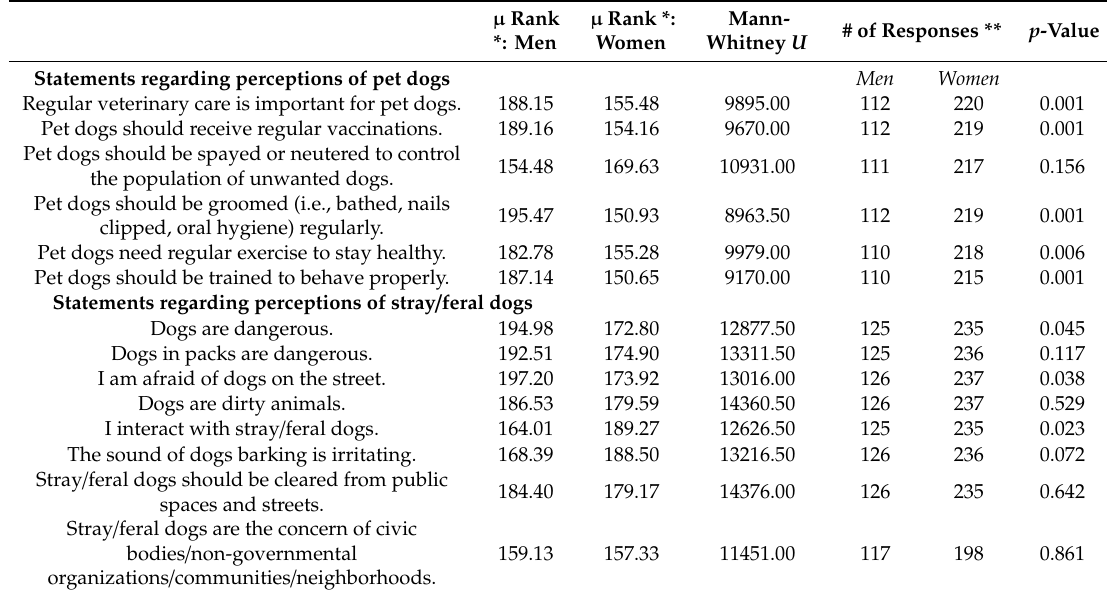
Table 2. Likert scaled statements and associated p -values for sex di ff